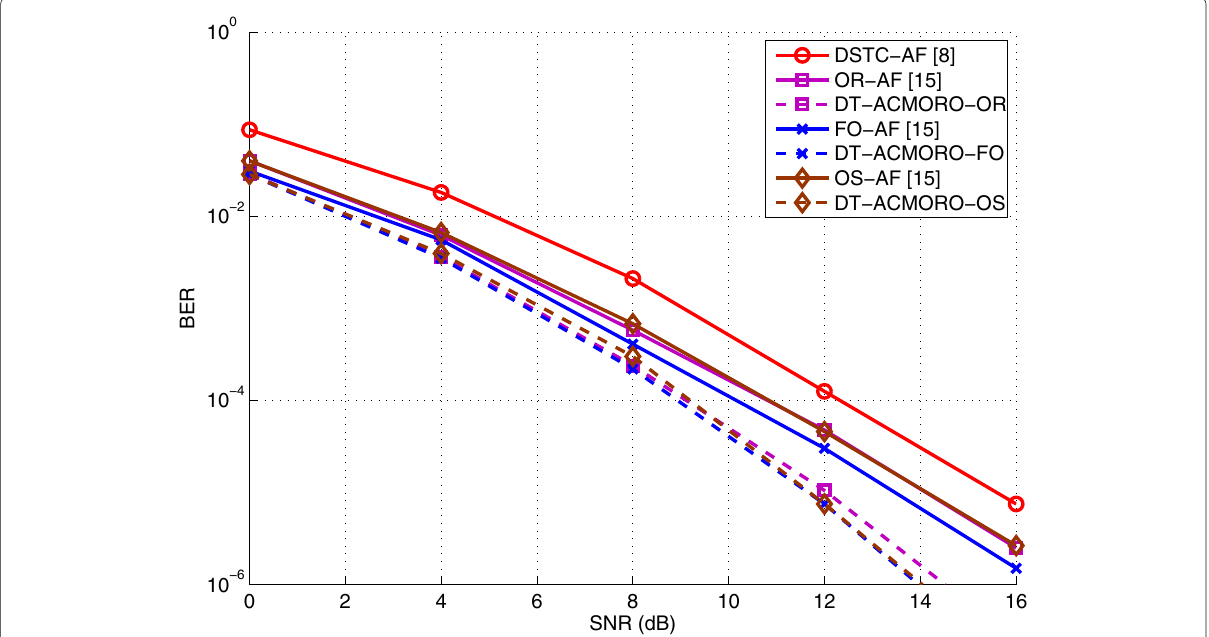
Fig. 5 BER performance vs. SNR for DT-ACMORO SG algorithm for